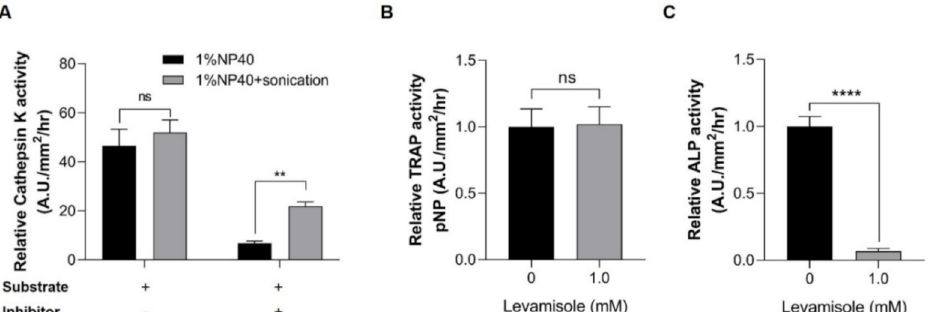
Figure 3. Inhibitor specificity in enzyme assays. ( A ) Cathepsin K activity. The lysates extracted under 1% NP-40 only (black bar) and 1% NP-40+sonication (gray bar) conditions were used in the cathepsin K assay. The lysates were incubated with a substrate and the presence (+) or absence ( − ) of cathepsin K inhibitor. The enzymatic activity was calculated as the ratio between the fluorescence values of the lysate and background (relative to 1), ( B ) TRAP activity, and ( C ) ALP activity. Lysates extracted under 1% NP-40 and sonication conditions were incubated with an acidic buffer and an alkaline buffer containing pNPP and 1 mM levamisole (an ALP inhibitor) to measure the activities of TRAP and ALP, respectively. These activities were determined using the UV spectroscopy method ( λ = 405 nm). Values are presented as the mean ± SEM. Significant differences were calculated by Student’s t -test, with **** p ≤ 0.0001; ** p ≤ 0.01; ns: not significant. Error bars indicate the standard error of the